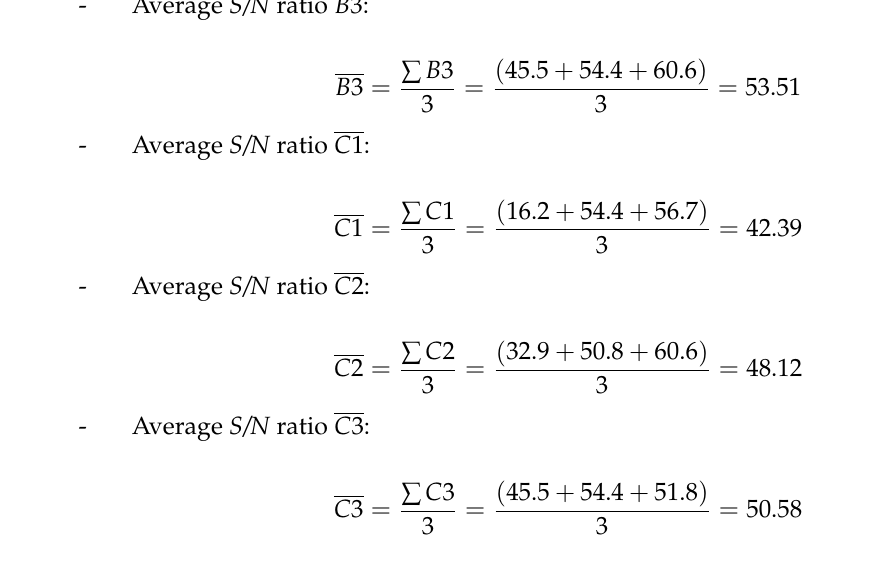
Table 8. Material removal rate and S/N ratio.